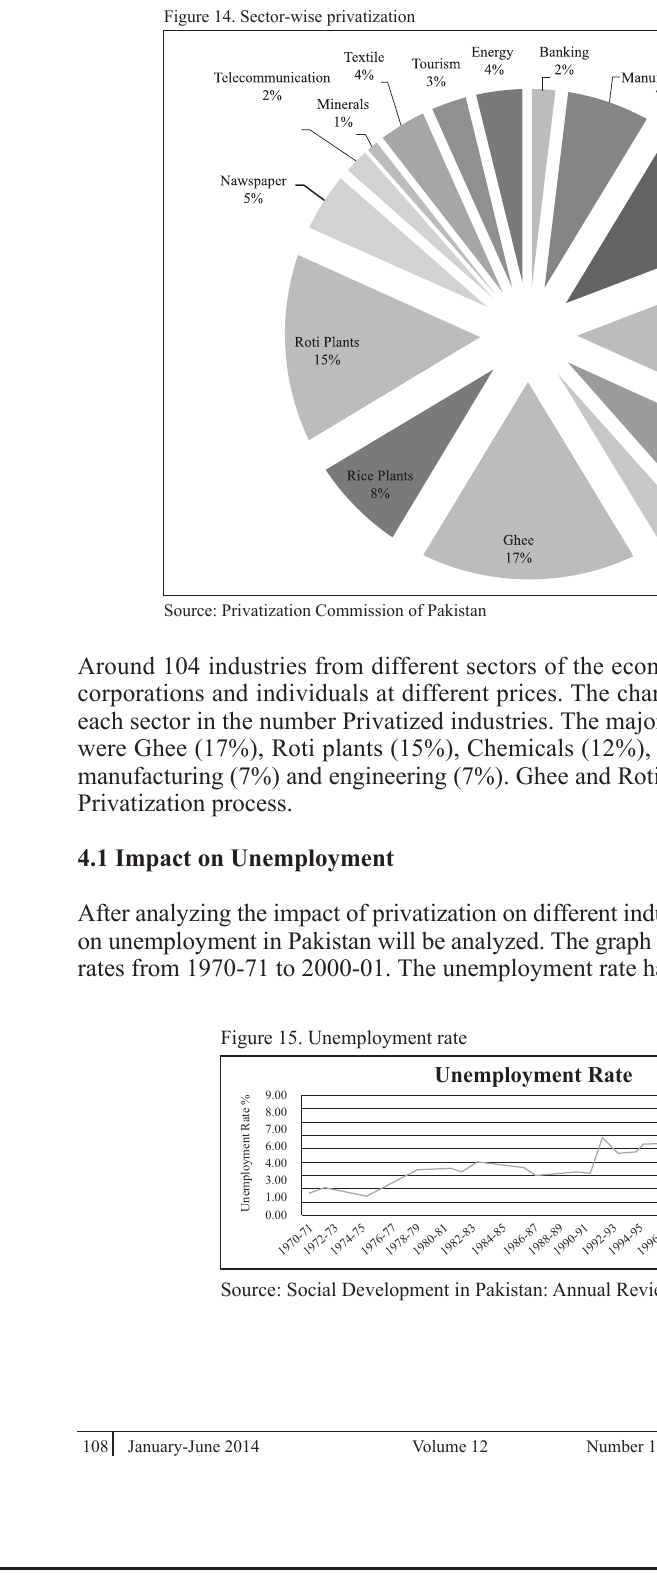
Figure 14. Sector-wise privatization